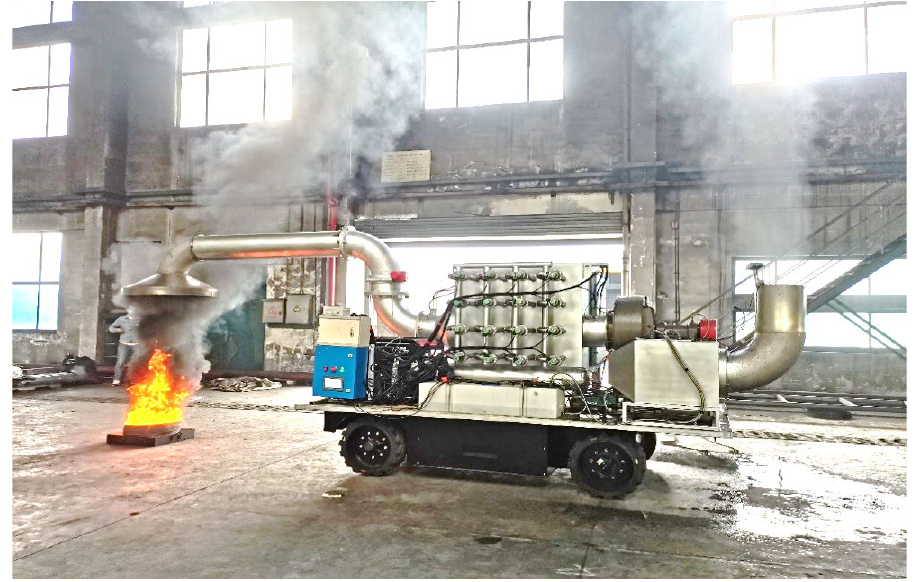
Figure 8. Working state of the FSDS during the test.